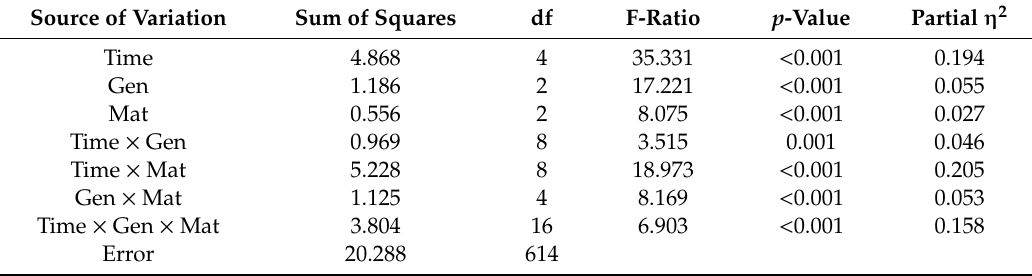
Table 2. ANOVA summary table for the reduced ascorbic acid.